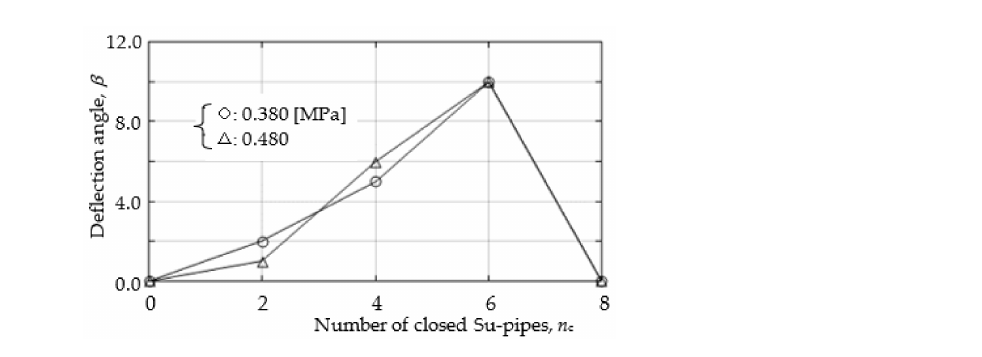
Figure 4. Deflection angle, β ( P 0 = 0.38, 0.48 MPa): The deflection angle has a maximum value of β = 10 ◦ at n c = 6.